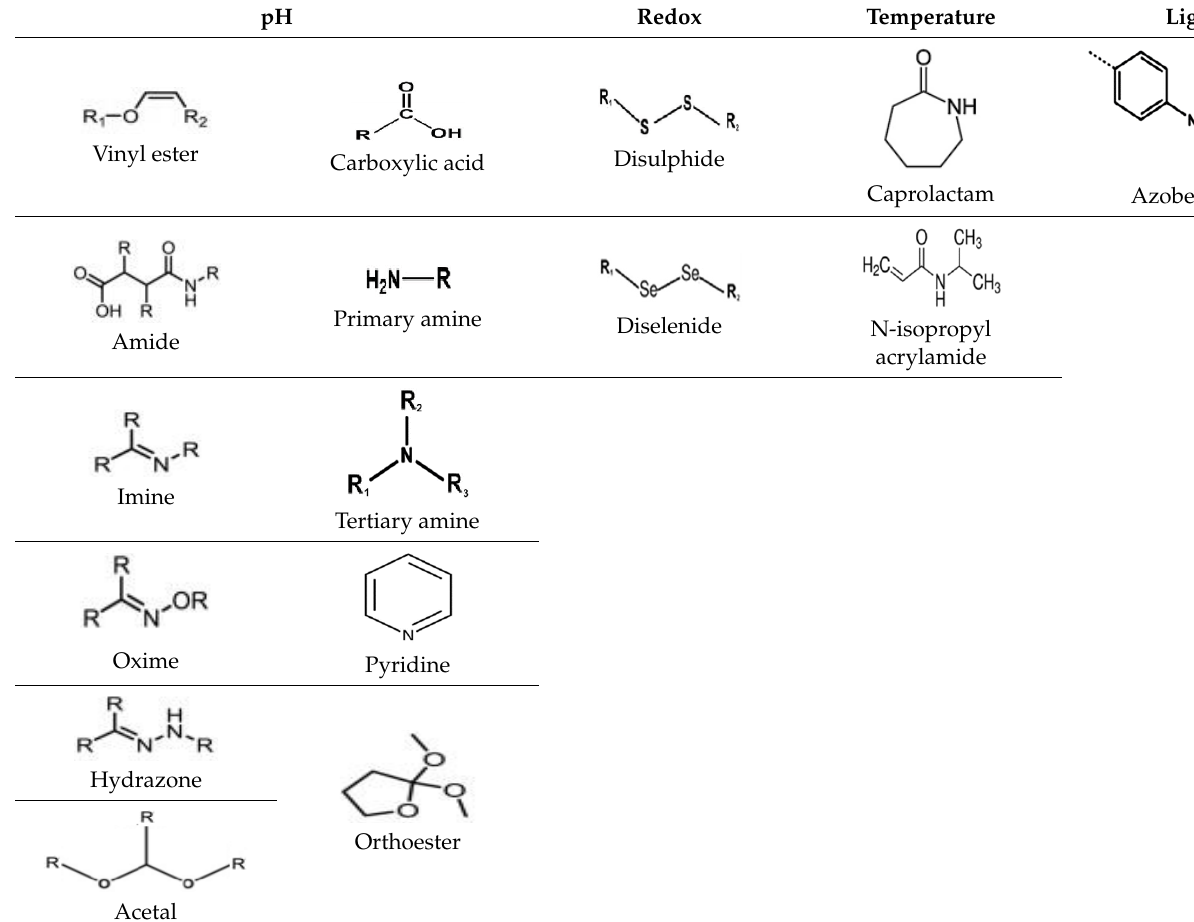
Table 1. Common stimuli-responsive functional groups.